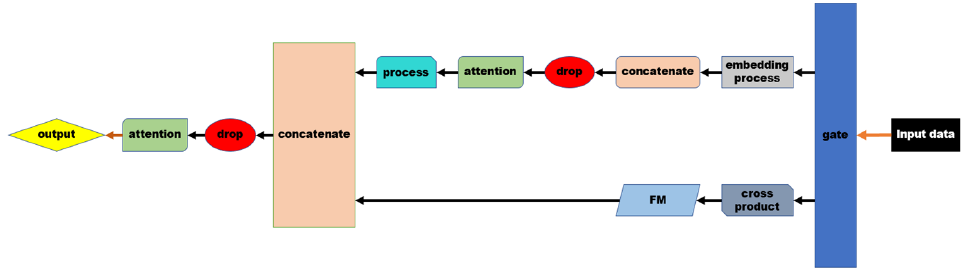
Figure 1. Main structure of GAFM.